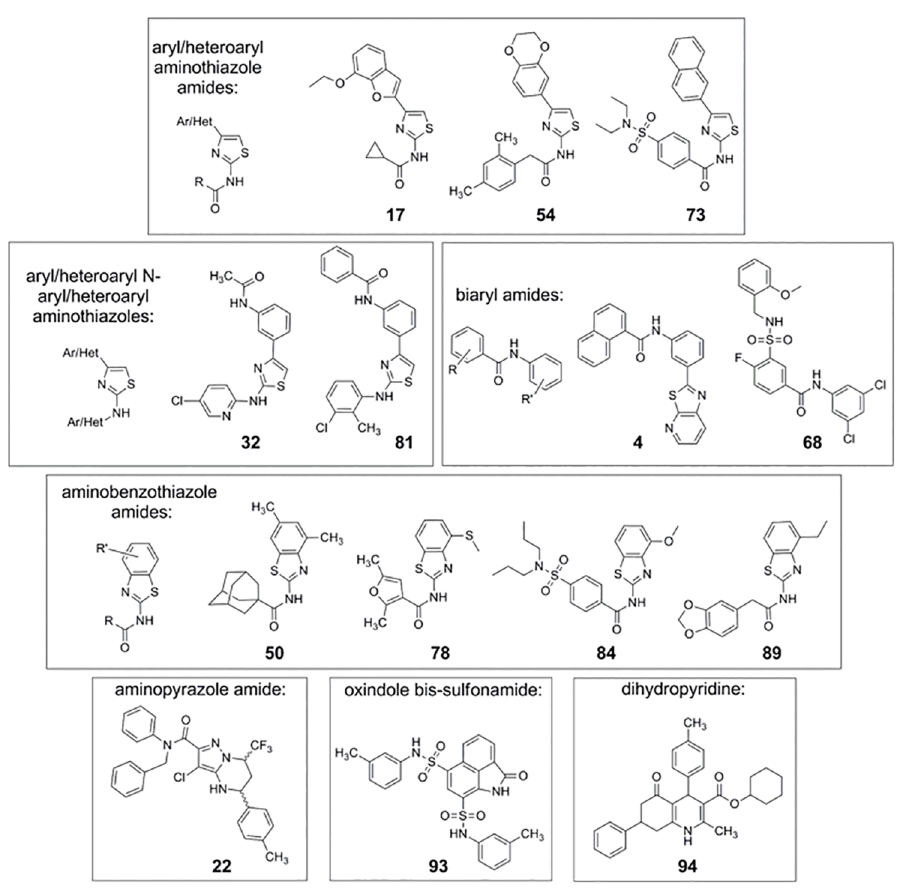
Fig 6. Pharmacoperones used in this study, showing that compounds in many different structural classesrescue the mutant L83Q. The 14 compounds shown have beengroupedinto 7 structure classes.